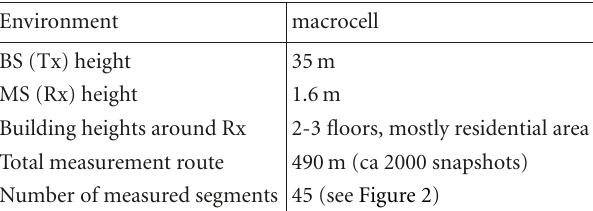
Table 2: Measurement environment.